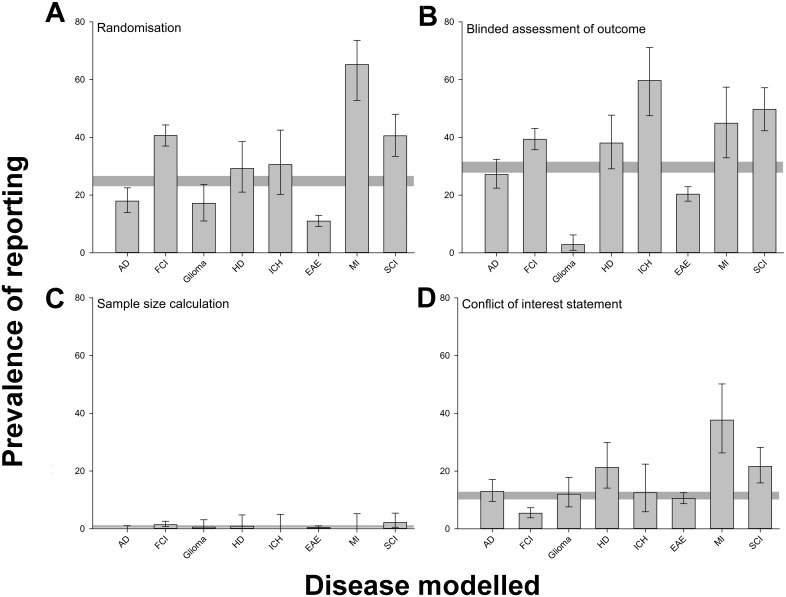
Prevalence of reporting of (A) randomisation, (B) blinded assessment of outcome, (C) sample size calculations, and (D) conflict of interest reporting in 2,671 publications describing the efficacy of interventions in animal models of Alzheimer’s disease (AD, n = 324 publications), focal cerebral ischaemia (FCI, 704), glioma (175), Huntington’s disease (HD, 113), intracerebral haemorrhage (ICH, 72), experimental autoimmune encephalomyelitis (EAE, 1029), myocardial infarction (MI, 69), and spinal cord injury (SCI, 185) identified in the context of systematic reviews.Vertical error bars represent the 95% confidence intervals, and the horizontal grey bar represents the 95% confidence interval of the overall estimate (S2 Data).